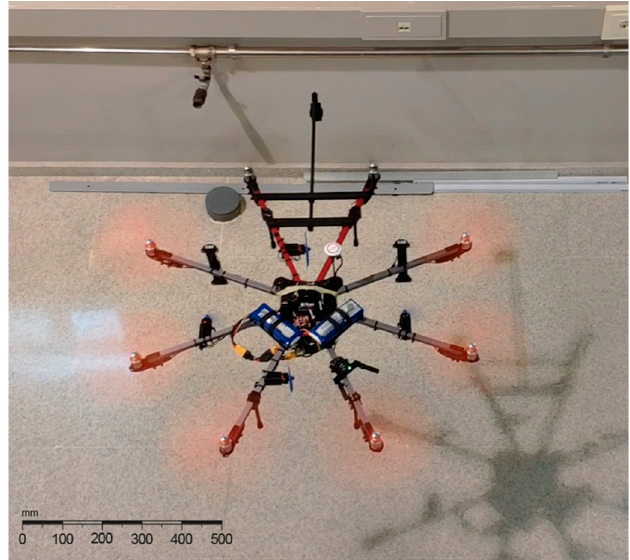
Figure 8. UAV flying close to a wall during the final test. The proposed NWPS and horizontal movement hardware are used to hover at a fixed distance to the wall.